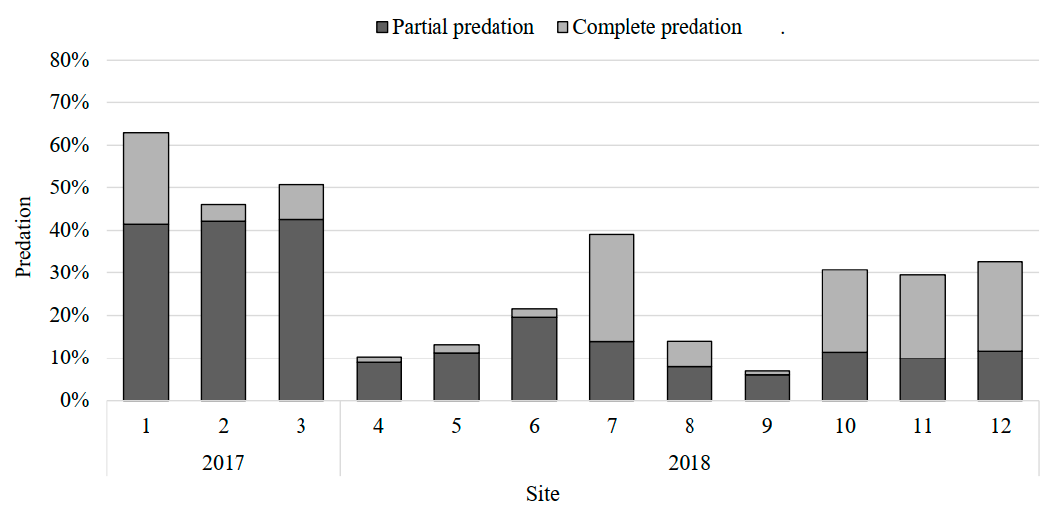
Figure 1. Predation level on Spodoptera frugiperda eggs in 12 Guanajuato localities, Central Mexico, during 2017 to 2018. Table 1. Locality, municipality and quantity of recovered masses of Spodoptera frugiperda in